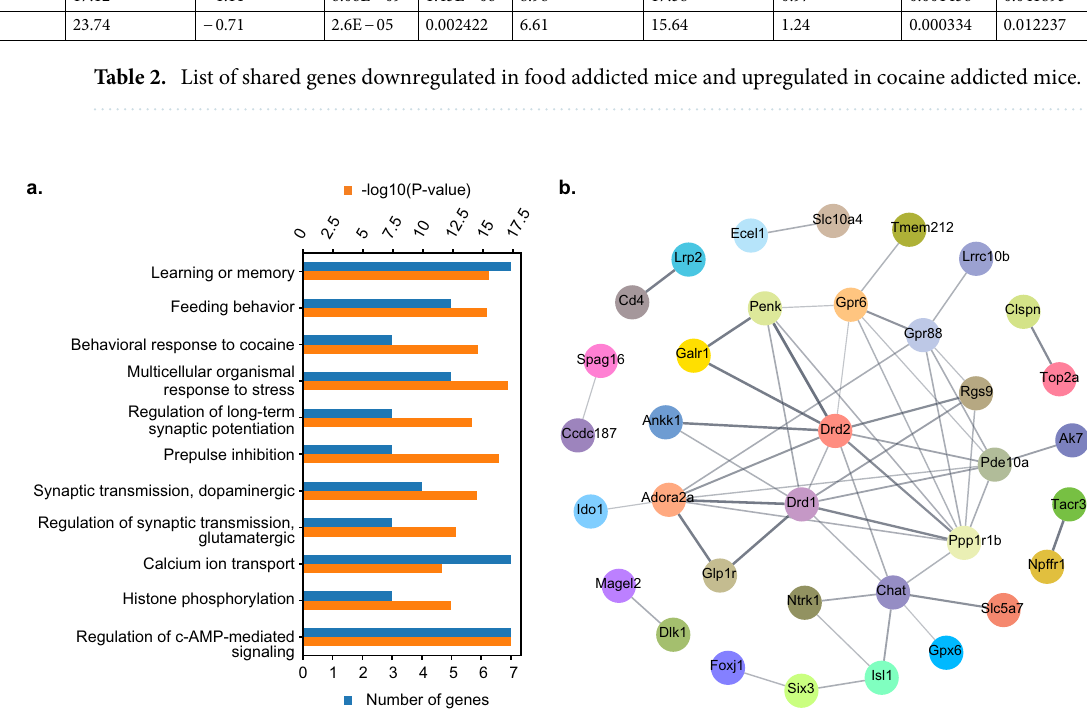
Figure 2. GO and gene association network analysis of shared genes in food and cocaine addiction-like behavior. ( a ) Bar plot representing the behavioral, biological, and molecular processes. Number of genes and − log 10 (p-value) in red and blue, respectively. ( b ) Protein–protein interaction network of shared genes in palatable food and cocaine addiction. The thickness of an edge represents the confidence score for the given